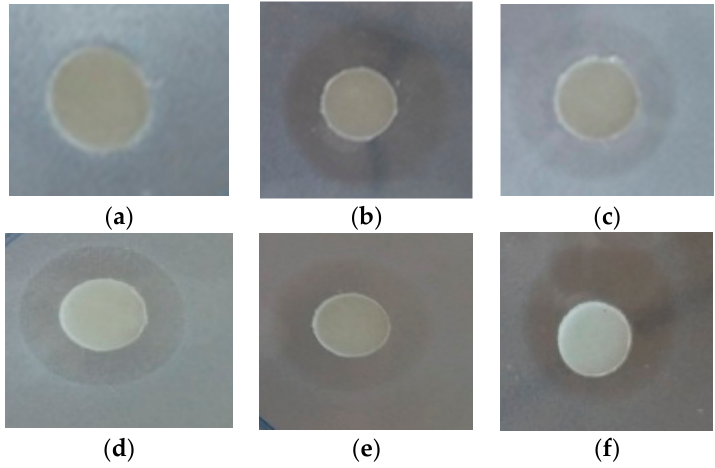
Figure 3. Antibacterial activity with agar diffusion test; where ( a ) elution buffer as blank; ( b – f ) inhibition zone against E. coli ER2566, BL21, Rosetta, JM109 and DH1, respectively. The testing solution contains purified cecropinB2 (10 μ g/mL) in the elution buffer.